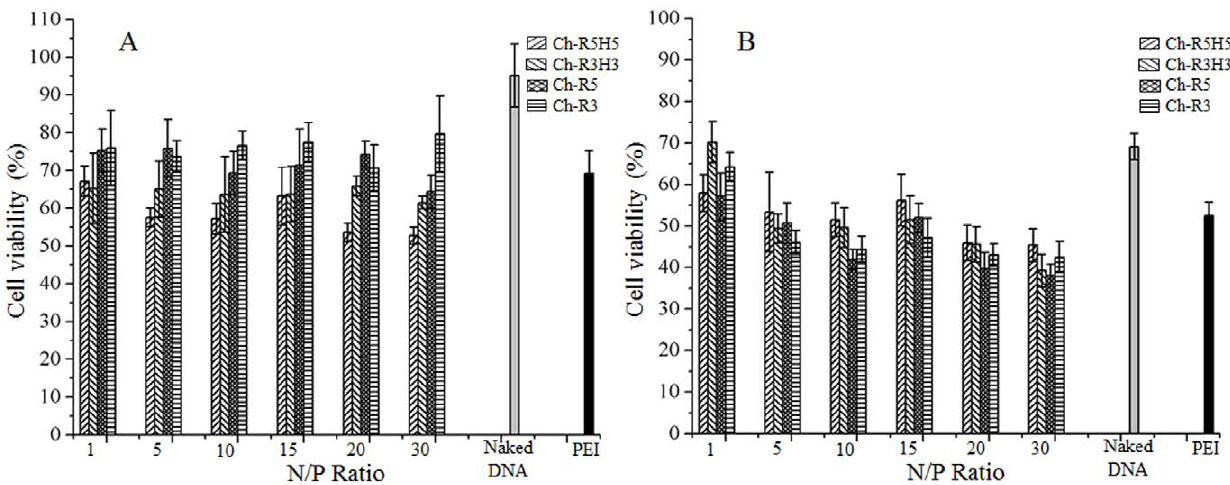
Figure 5. Cell viability of mammalian cells after incubation with Ch-R5H5-DNA, Ch-R3H3-DNA, Ch-R5, and Ch-R3 complexes at different N/P ratios compared to DNA and PEI/DNA complex at an N/P ratio of 10. Error bars represent standard deviation of 8 replicates. Panel A. HEK-293 cell line. Panel B. MCF-7 cell line.